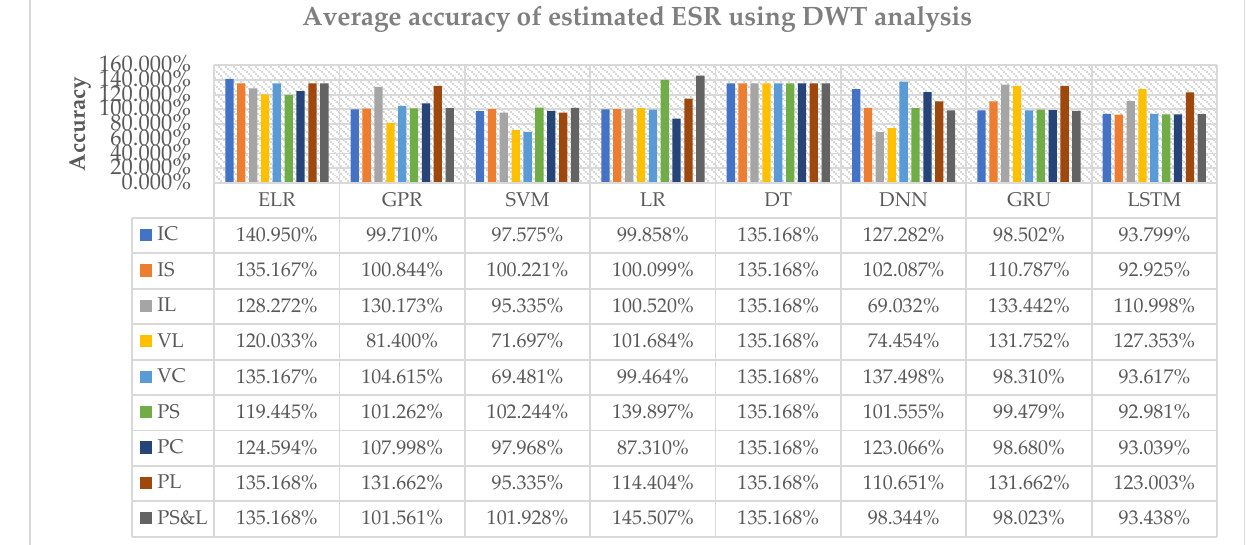
Figure 13. Average accuracy of the estimated capacitance using discrete wavelet transform (DWT) analysis .